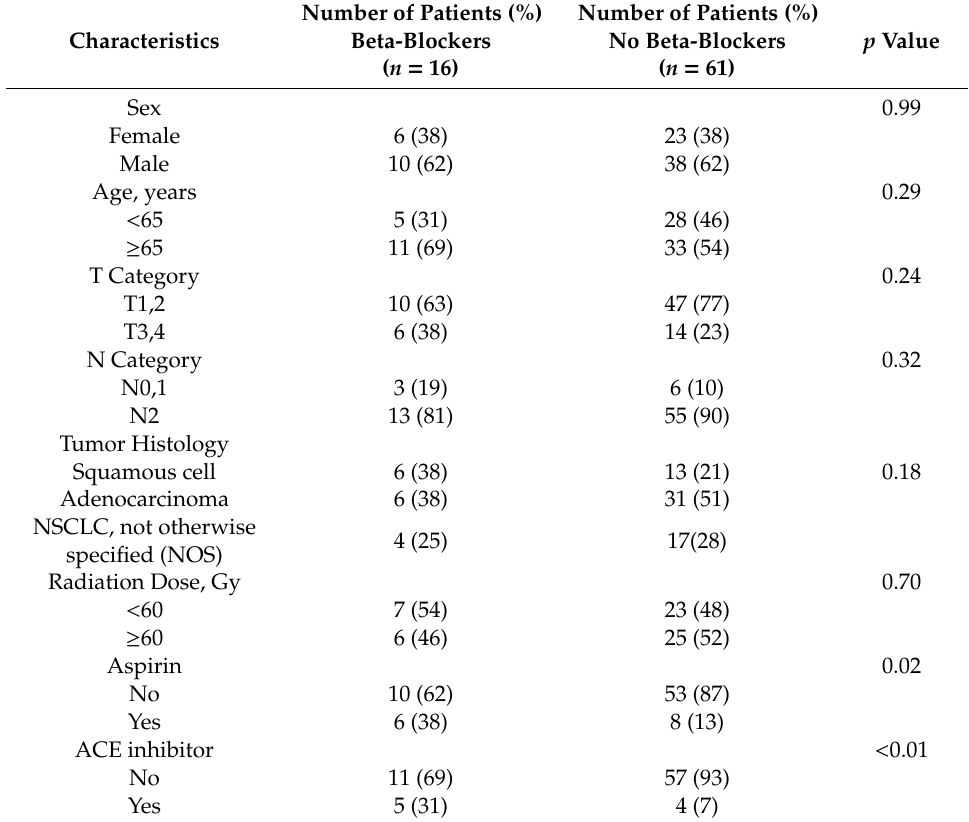
Table 1. Patient and tumor characteristics. NSCLC: non-small cell lung cancer; ACE: angiotensin-converting